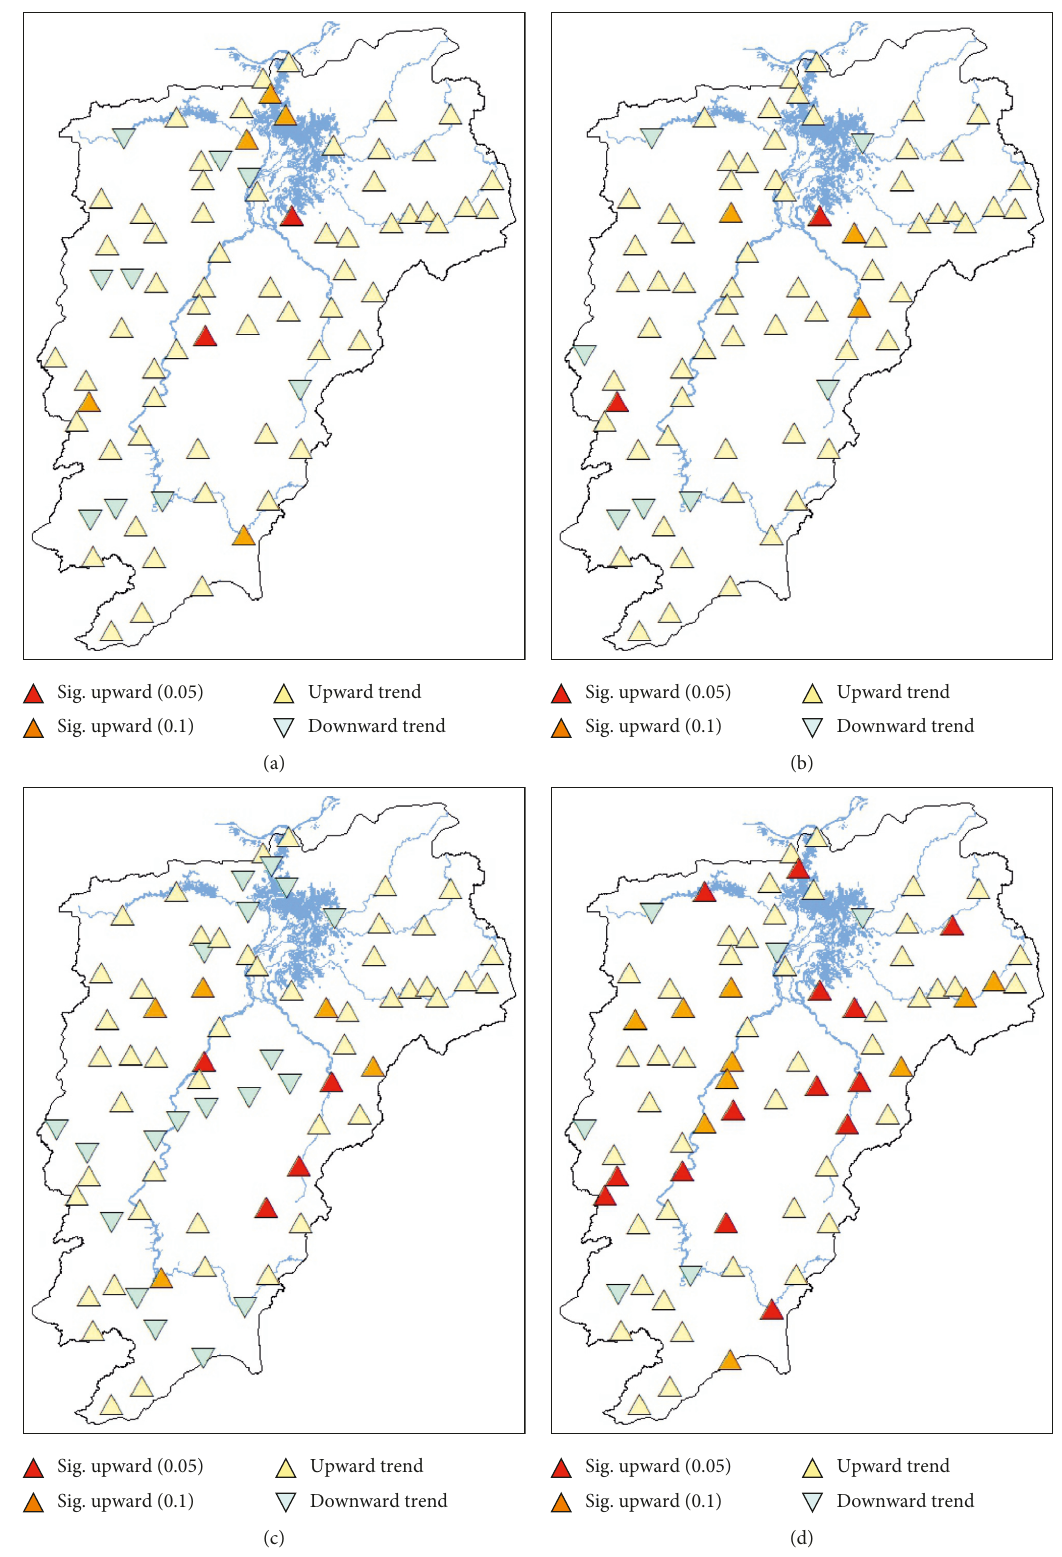
Figure 6: Spatial patterns of long-term trends for (a) EPD, (b) EPA, (c) EPI, and (d) EPR in the Poyang Lake basin during